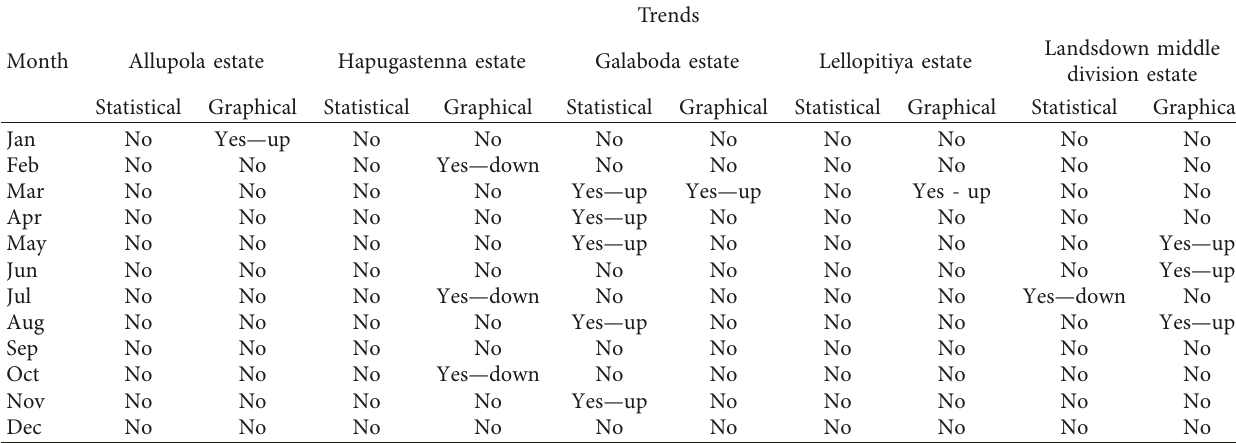
Table 7: Comparison results for monthly rainfalls for Denawaka Ganga catchment.